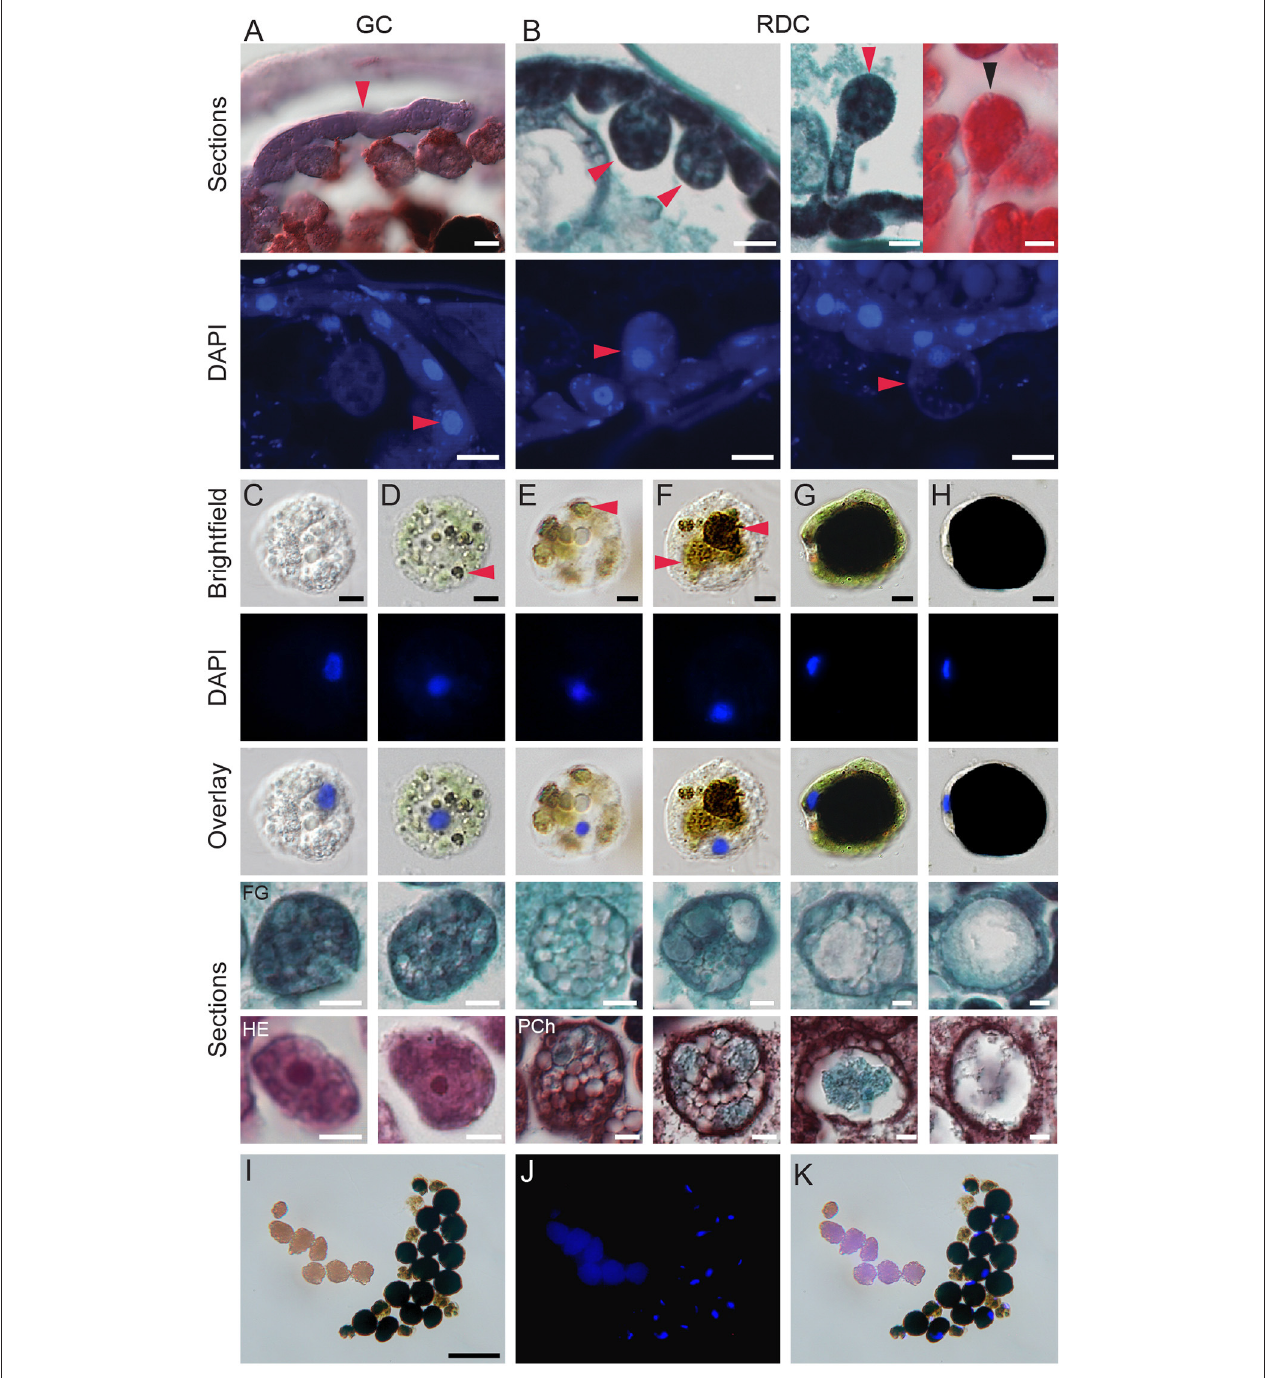
FIGURE 5 | Development of digestive cells in spider mite midgut. (A) Brightfield microscopy (cryosection, Oil Red O staining) and fluorescence microscopy (paraffin sections, DAPI staining) of generative cells (GC) forming midgut epithelium. (B) Brightfield microscopy (paraffin sections, Fast Green and Safranin O, and Hematoxylin and Eosin staining) and fluorescence microscopy (paraffin sections, DAPI staining) of residual digestive cells (RDC) as they grow into the midgut lumen and detach from the midgut epithelial layer. (C–H) Digestive cells (DC) at various stages of development. DCs were dissected from the midgut lumen of female spider mites, stained using DAPI, and observed using brightfield and fluorescence microscopy. Lower panels, paraffin sections of DCs from different staining preparation: FG, Fast Green/Safranin O; HE, Hematoxylin/Eosin and Pch, Pentachrome. (C) Stage 1, the early stage of DC development with clear but numerous vesicles and